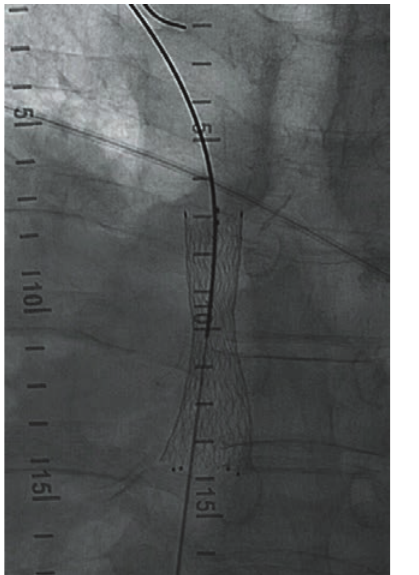
Fig. 3. Cavography after stent implantation and balloon angioplasty. Presentation of the stented uncaged superior vena cava with correct stent position and a regression of collateral